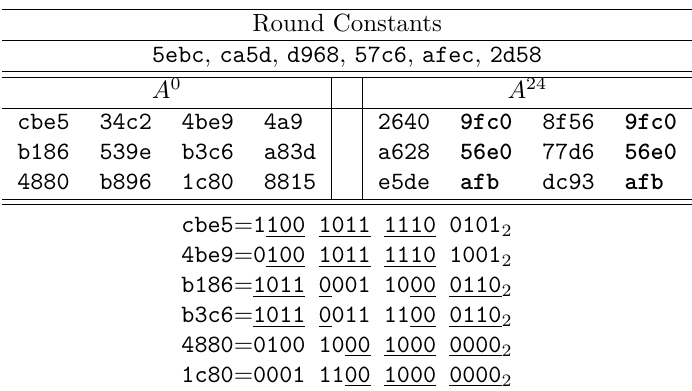
Table 3: An example of the desired pair ( A 0 , A 24